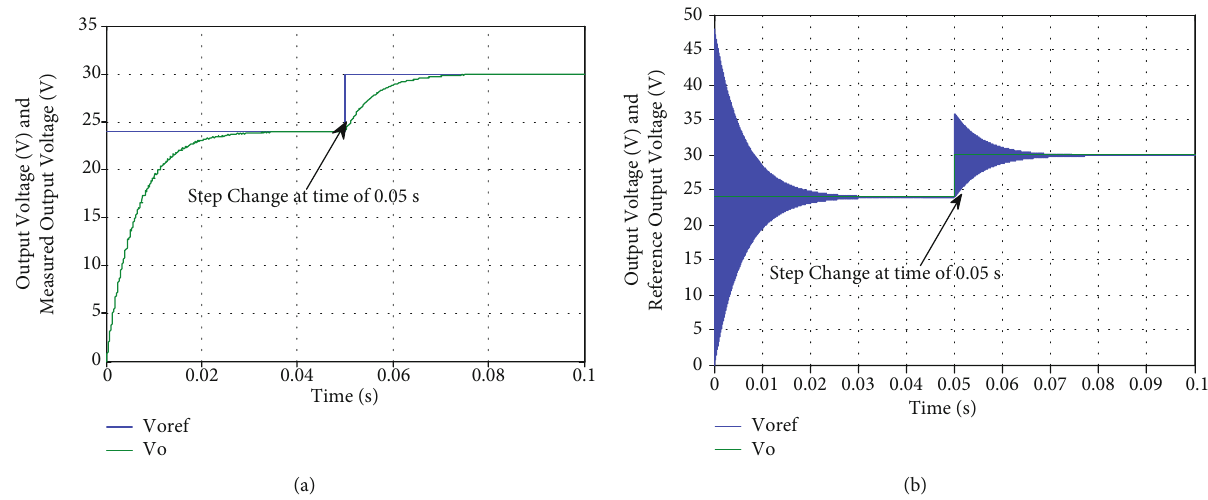
Figure 17: Response of V of FKYBC with designed controller when reference output voltage from 24 V to 30 V: (a) HPC and o (b) PID control.